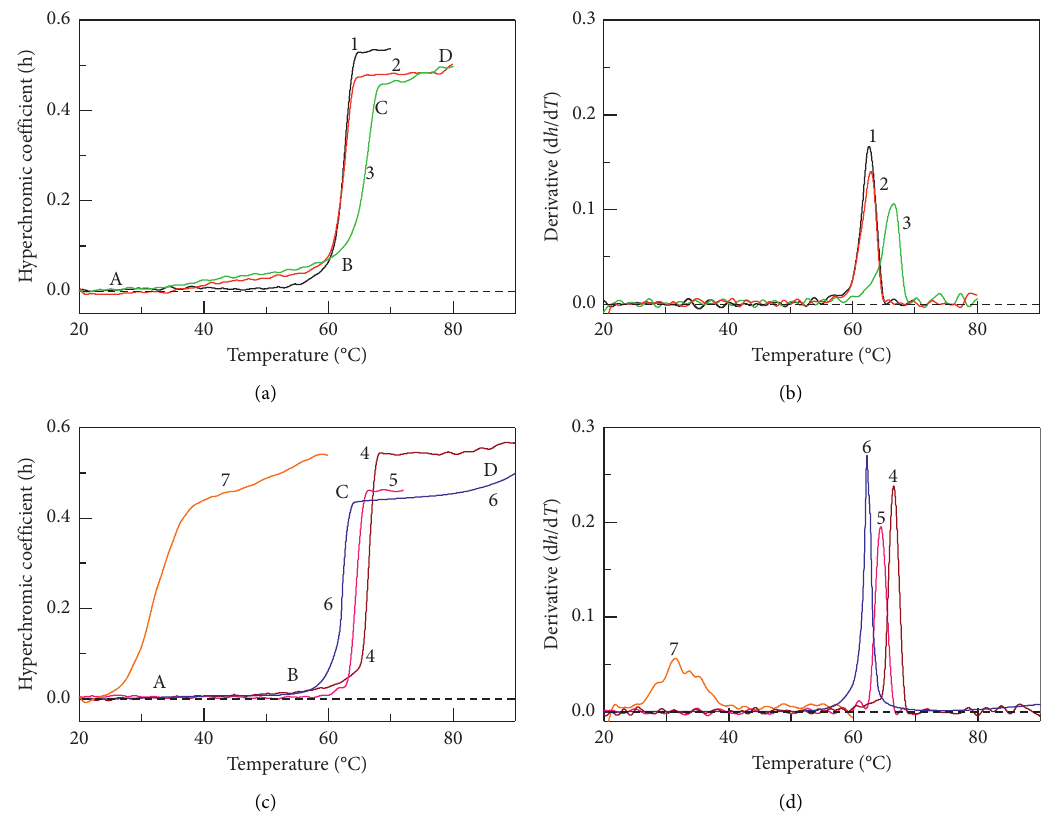
Figure 3: (a) Temperature dependence of hyperchromic coefficient of poly(I:C) in the presence of Mt 2+ : 1—[Mt 2+ ] � 0, 2—7.4 × 10 − 5 N Ca 2+ , 3—1.8 × 10 − 4 N Mn 2+ ; (b) the derivatives of the curves presented in (a); (c) h ( T ) curves of poly(I:C) doped with Mt 2+ : 4–5 × 10 − 4 N